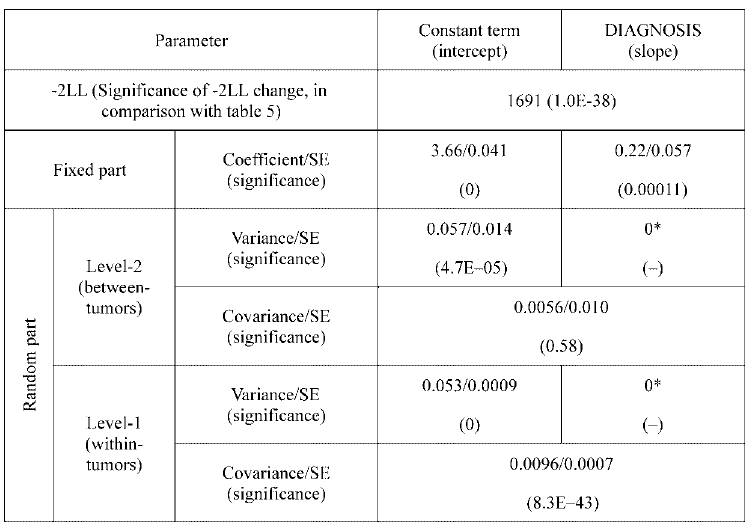
Model for log NA with DIAGNOSIS as random coefficient